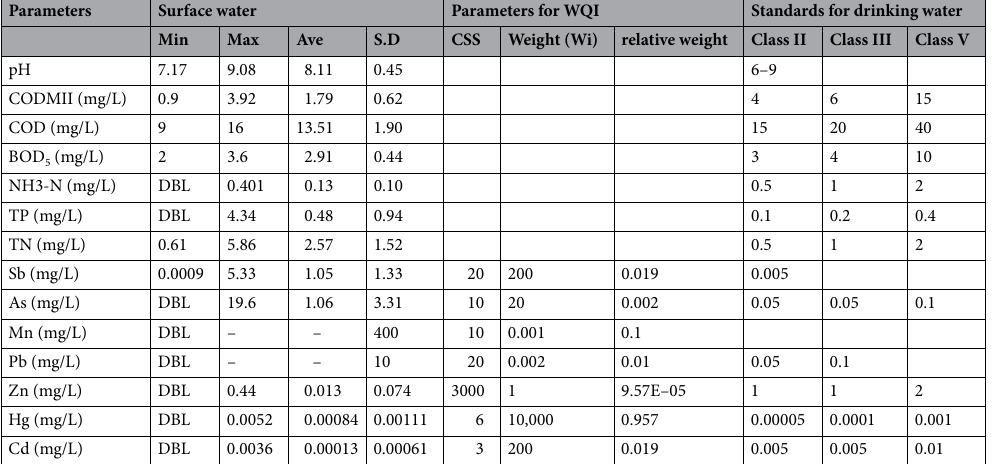
Table 2. Water quality indices and heavy metal concentrations in the surface water in XKS and the relative